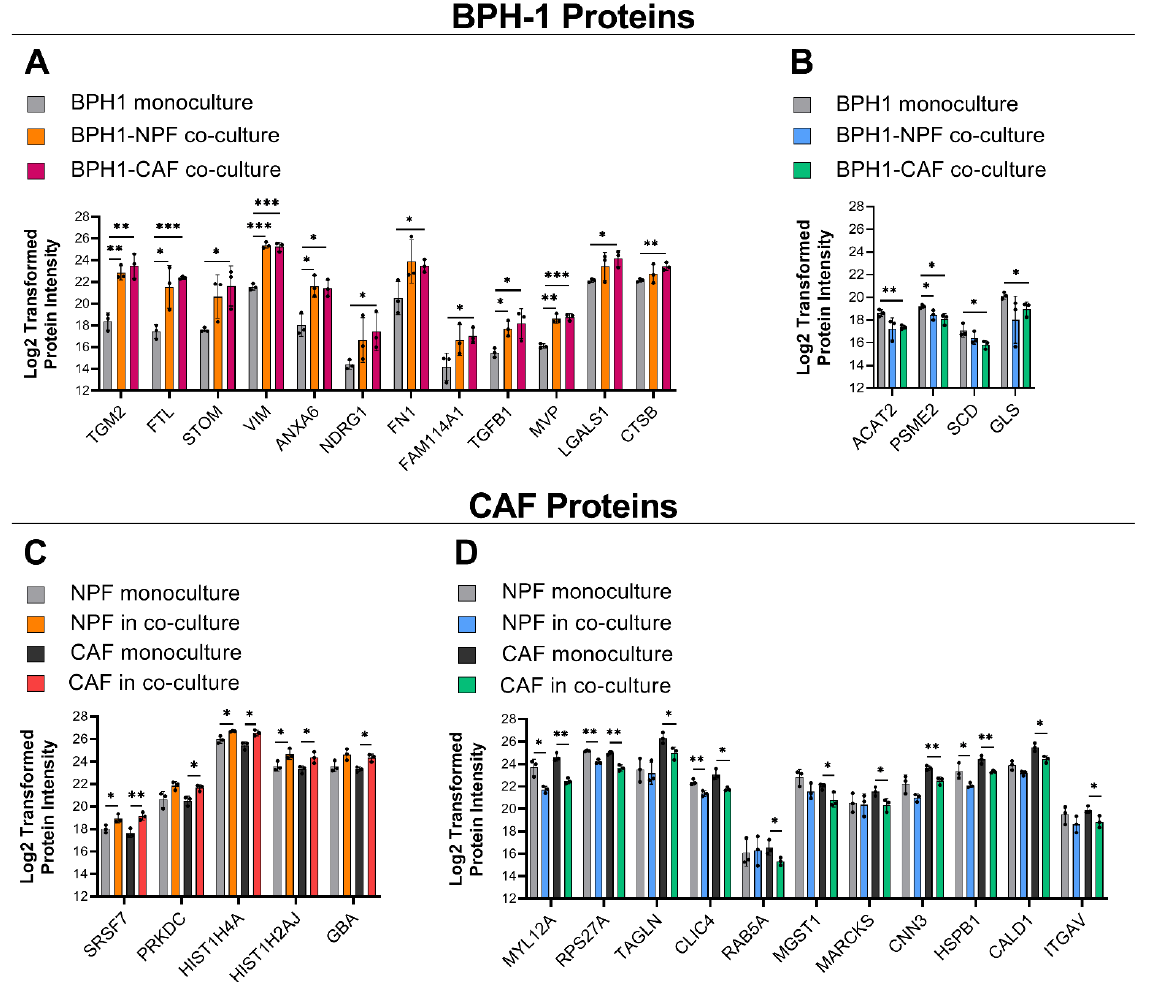
Figure 3. BPH-1 and fibroblast proteins differentially expressed in co-culture. A summary of BPH- 1 proteins with ( A ) increased and ( B ) decreased expression following co-culture with CAFs, and comparison with effect of NPF co-culture, and a summary of CAF proteins with ( C ) increased and ( D ) decreased expression following co-culture with BPH-1 cells, and a comparison with effects in NPFs when they are co-cultured with BPH-1 cells. Only proteins with a >twofold change in either direction in CAF co-culture conditions presented. Data represent mean protein abundance across 3 biological replicates with NPFs and CAFs from a single patient. Mean ± SD, n = 3. Student’s t -test. * p < 0.05, ** p <0.01, *** p <